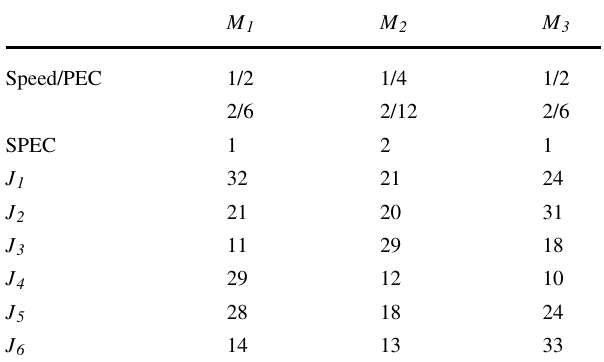
Fig. 3 Framework of the INSGA-II Table 1 The standard processing time and the unit energy consumption